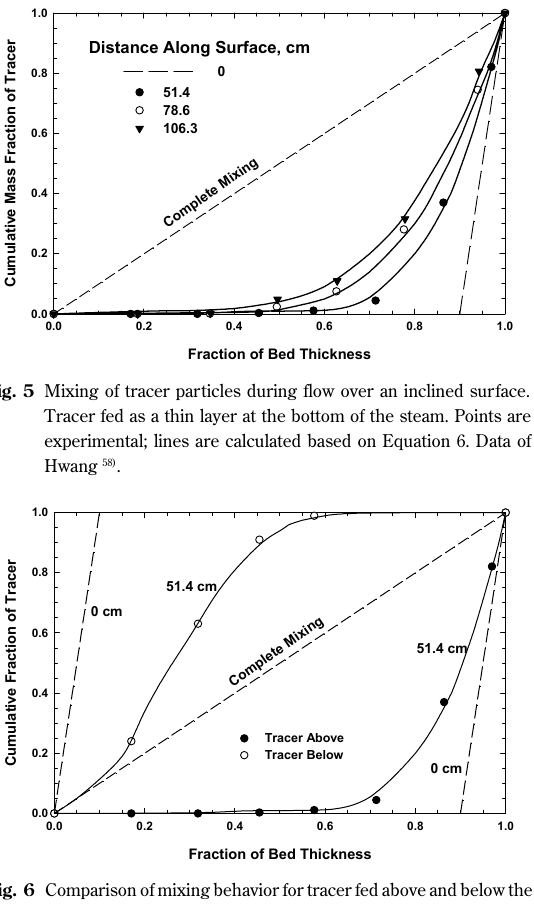
Fig. 6 Comparison of mixing behavior for tracer fed above and below the main flow stream. Calculated lines are based on the same values of the diffusion parameters. Data of Hwang 58) .